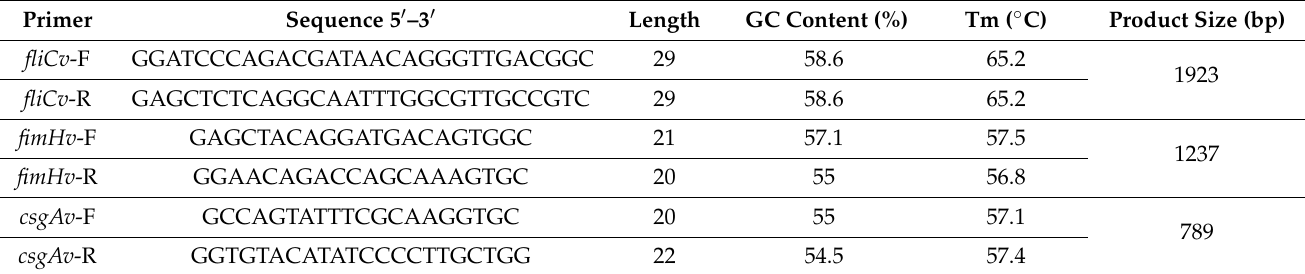
Table 3. Primers used to verify the inactivation of the fliC , fimH , and csgA genes in UPEC strain CFT073.